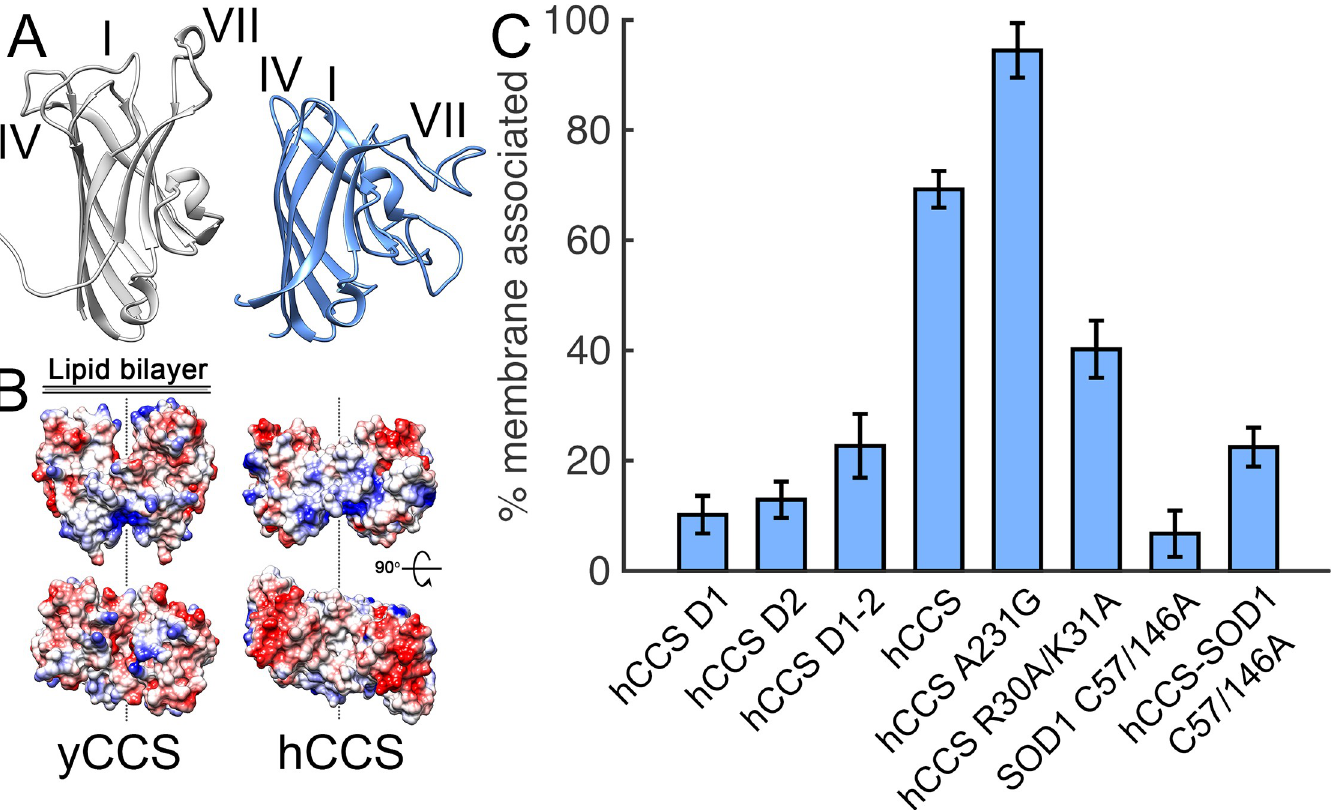
Fig 5. Dissimilar CCS membrane interaction surfaces. ( A ) The structure of domain II β -barrel loops I, IV, and VII are not conserved among yeast and human CCS orthologues. ( B ) Coulombic charge representation showing differing putative hCCS and yCCS domain II membrane-interacting surfaces. ( C ) Liposome-binding assay showing how the concerted effect of all three hCCS domains facilitate membrane association (S7C and S7D Fig). hCCS dimer affinity, domain I electropositivity, and complexation with SOD1 all effect lipid association. Mean ± SEM, n = 5. CCS, copper chaperone for SOD1; hCCS, human copper chaperone for SOD1; SOD1, superoxide dismutase-1; yCCS, yeast copper chaperone for